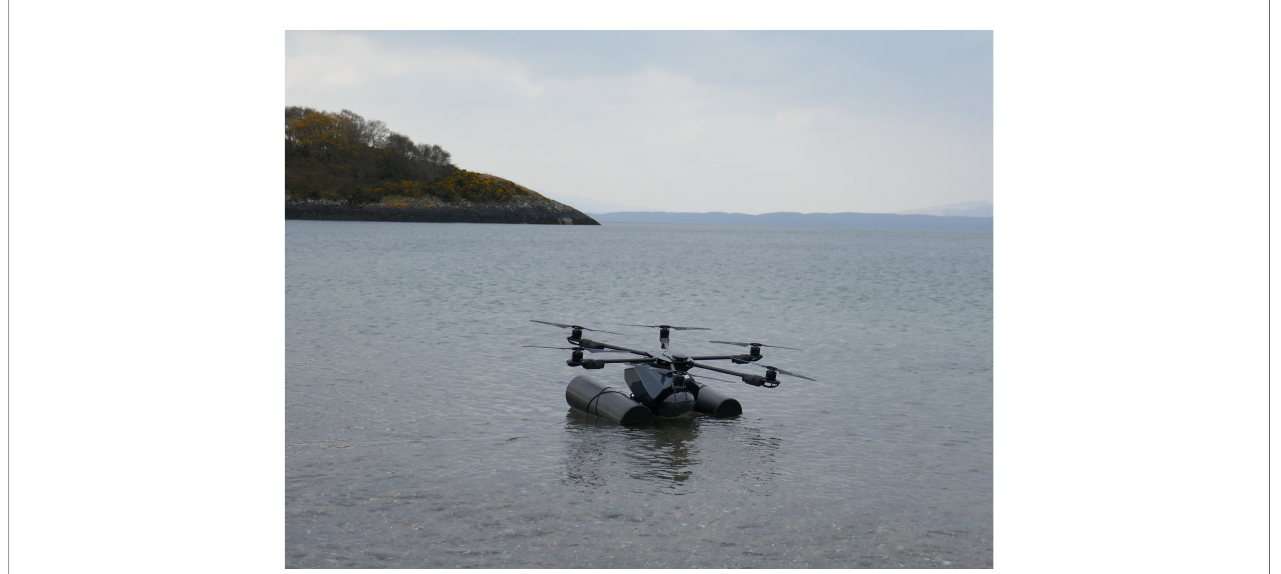
FIGURE 8 | TD7 water-landable UAV under trial on a near calm and sheltered embayment at Dunstaffnage Peninsula, Argyll,